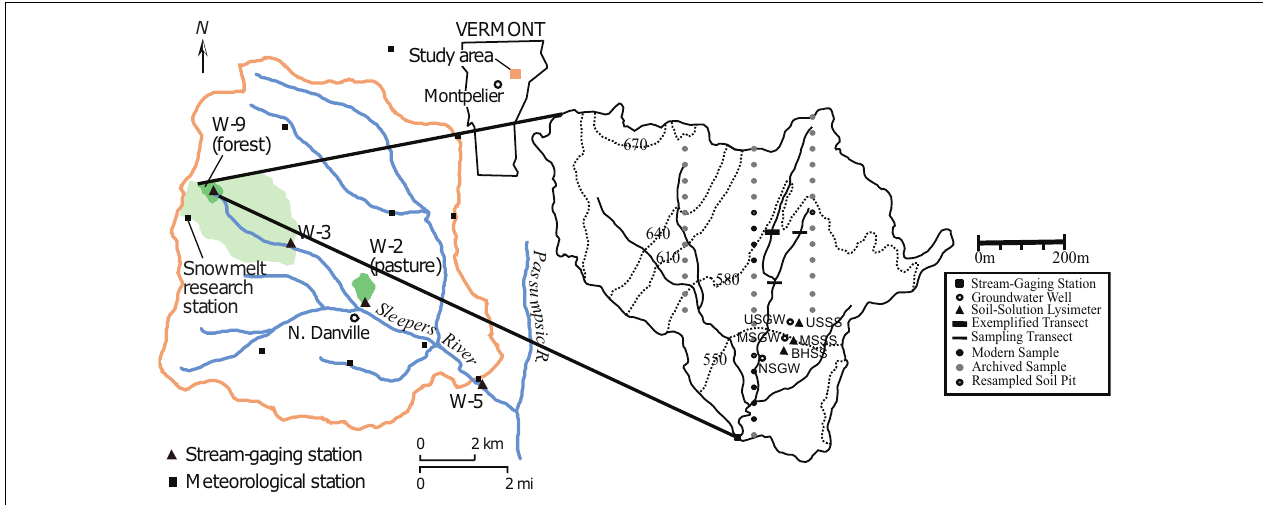
FIGURE 1 | Location of the Sleepers River watershed and nested subwatershed in Vermont with locations of well, soil pits and augered transects (modified after Kendall et al., 1999; Shanley, 2000, with